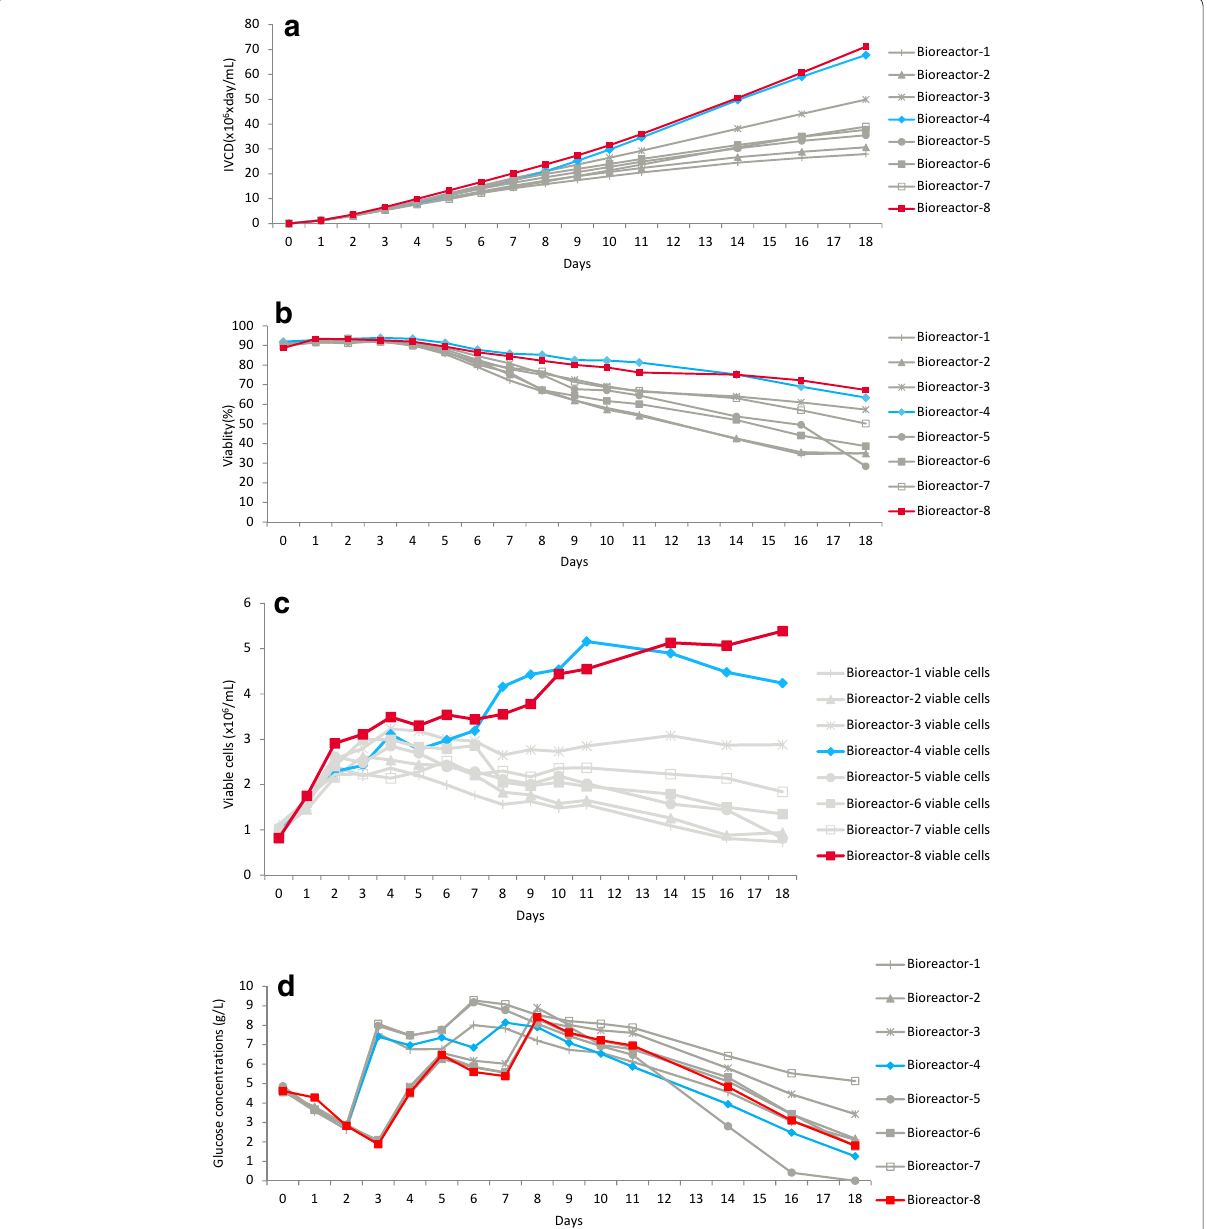
Fig. 1 a DOE optimization study evaluating three process parameters; integrated viable cell density of CHO cells in 0.3 L bioreactors shown over 18 days of growth. b DOE optimization study evaluating three process parameters; cell viability of CHO cells in 0.3 L bioreactors shown over 18 days of growth. c DOE optimization study evaluating three process parameters; Viable cell density of CHO cells in 0.3 L bioreactors over 18 days of growth. d DOE optimization study evaluating three process parameters; Glucose concentrations during growth of CHO cells in 0.3 L bioreactors shown over 18 days of growth. e DOE optimization study evaluating three process parameters; Lactate concentrations during growth of CHO cells in 0.3 L bioreactors shown over 18 days of growth. f DOE optimization study evaluating three process parameters; Ammonium concentrations during growth of CHO cells in 0.3 L bioreactors shown over 18 days of growth. g DOE optimization study evaluating three process parameters; rFab titer in 0.3 L bioreactors shown over 18 days of